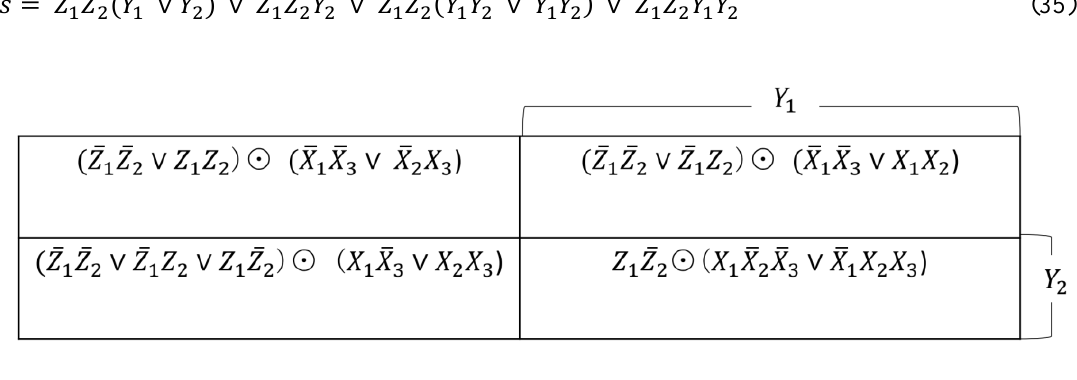
Fig. 8. A VEKM representing a function equivalent to ( 𝑠 ⊙ 𝑡 ) in Example